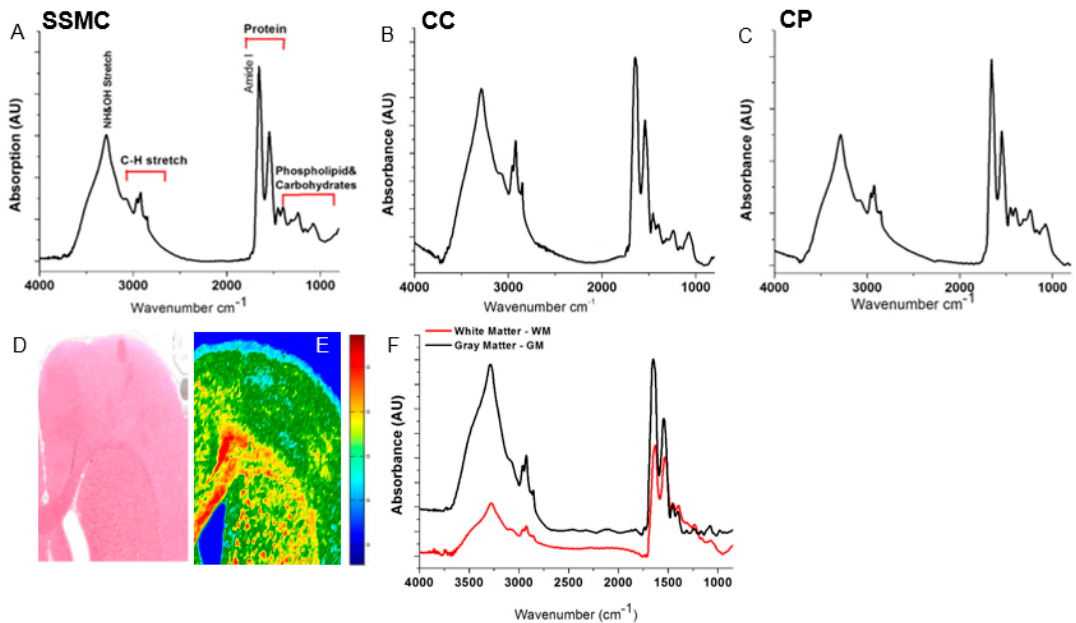
Figure 2. ( A – C ) Representative FTIR spectra of the SSMC, CC, and CP. ( D ) H&E images of the WM and the GM, and ( E ) FTIR image of the same region with a high-resolution, based on the lipid/protein ratio. ( F ) FTIR spectra of the WM and the GM. The color bar represents a high-concentration, in red, and a low-concentration, in blue.